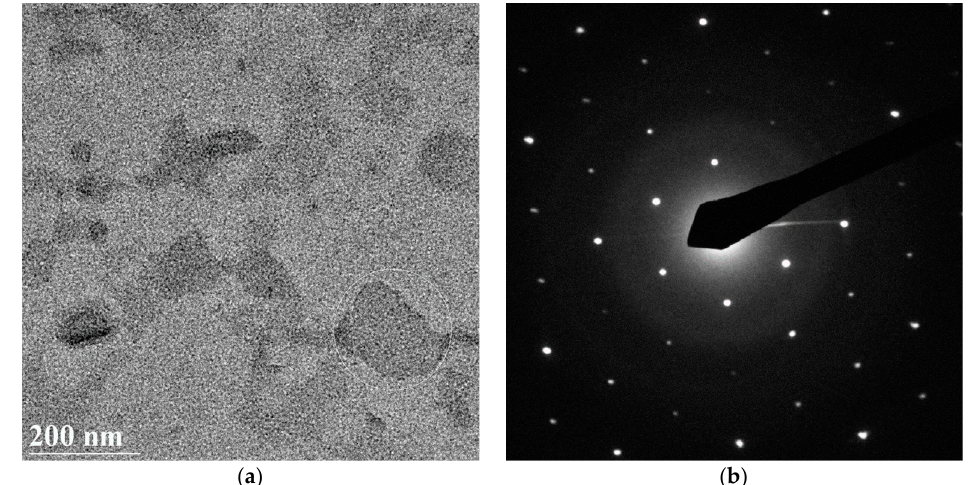
Figure 5. BF ( a ) and SAED pattern ( b ) of a bacteriorhodopsin membrane.